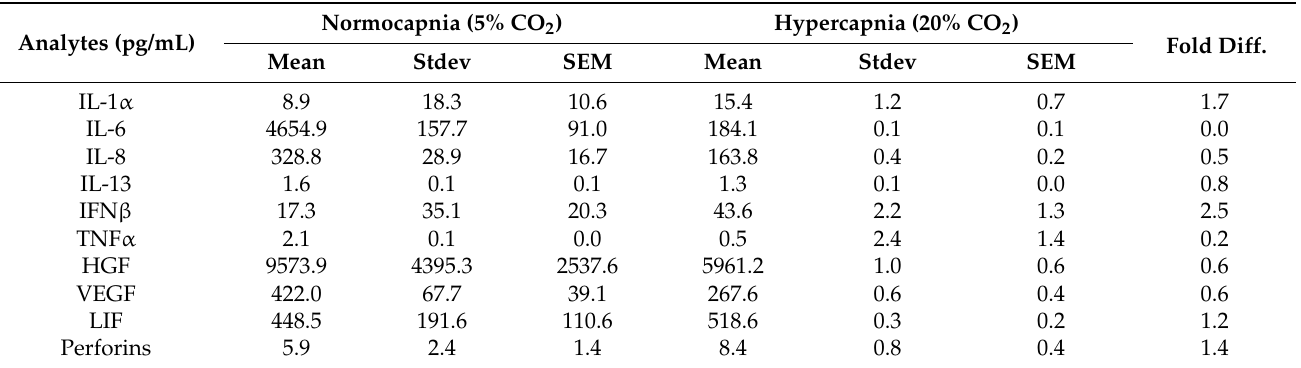
Table 2. The levels of secreted factors in supernatant of corneoscleral rim explant exposed to hypercapnia.